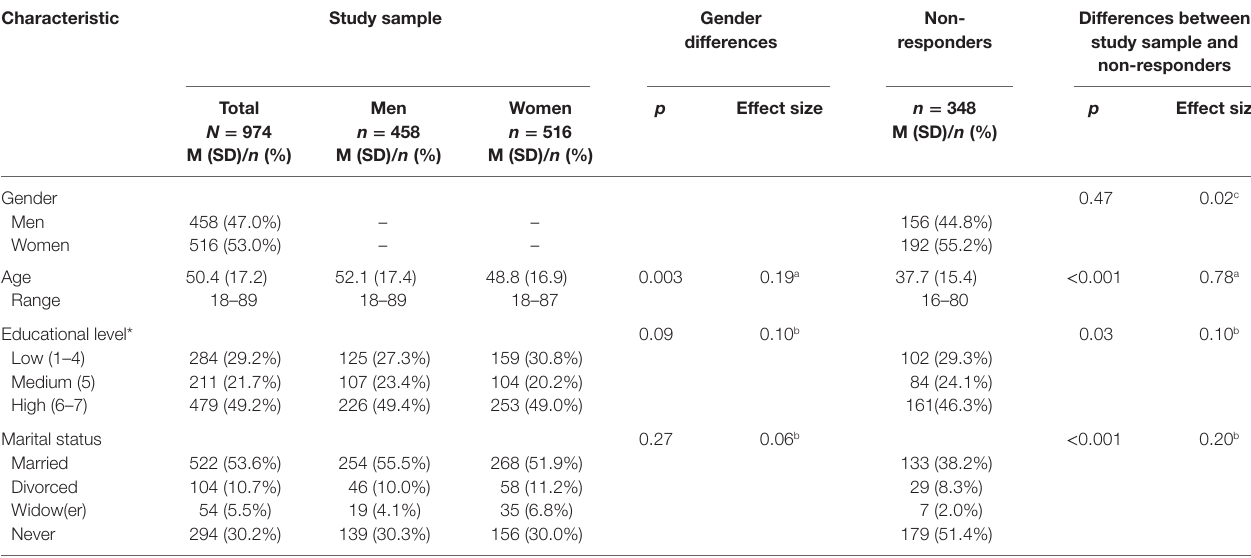
TaBle 1 | Sociodemographic characteristics of the study sample and the